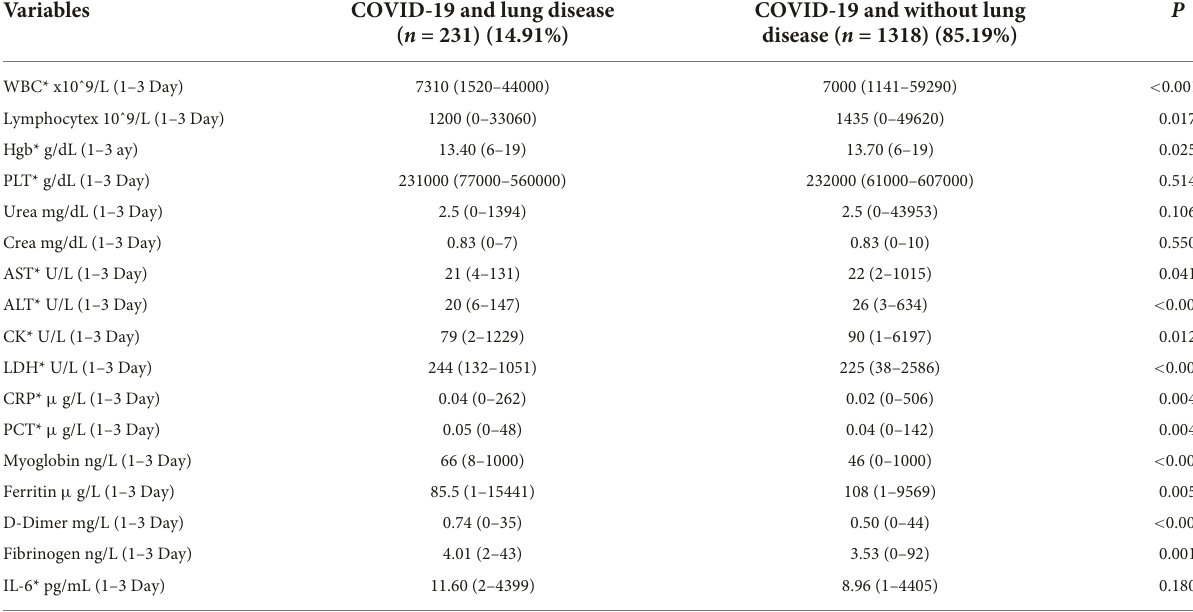
TABLE 3 The laboratory follow-up parameter of patients with chronic disease (Group 1) and without chronic lung disease (Group 2).